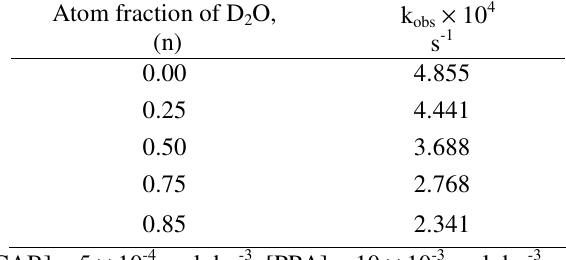
O-D O mixture at 2 2